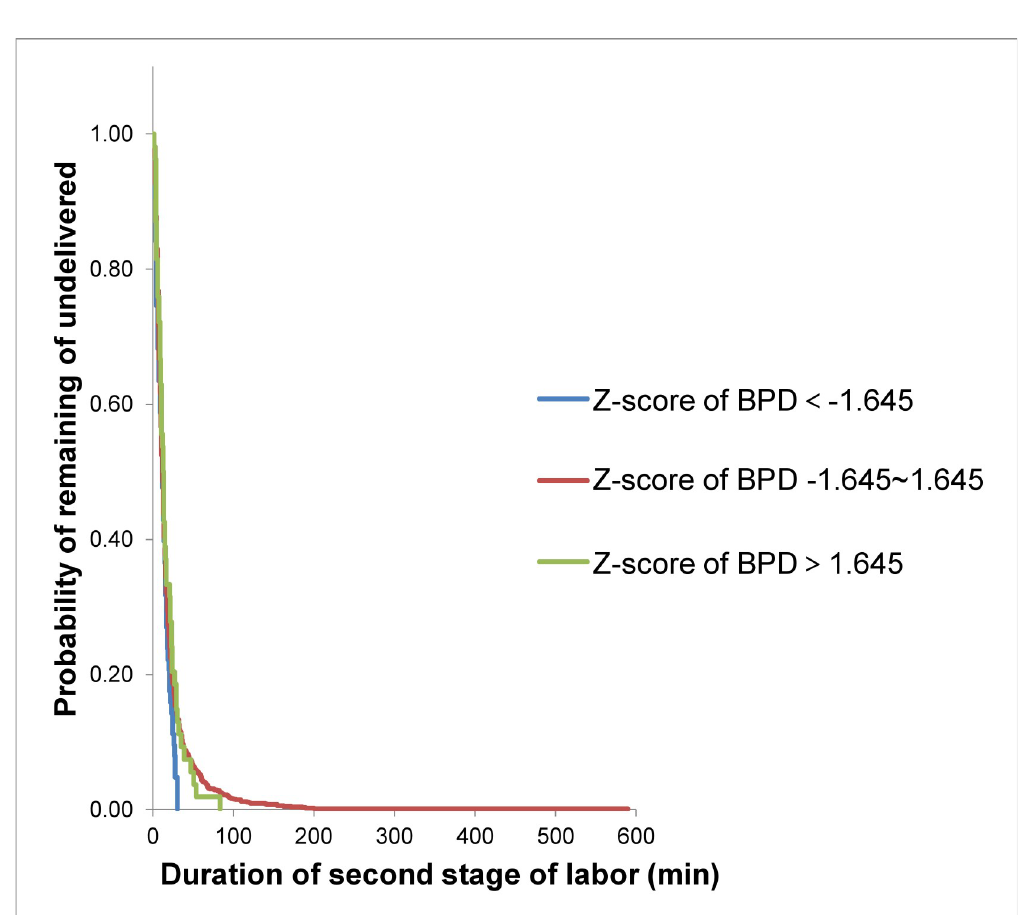
Fig 2. Kaplan-Meier analysis of the duration of second stage of labor according to Z-score of BPD in multiparous women.